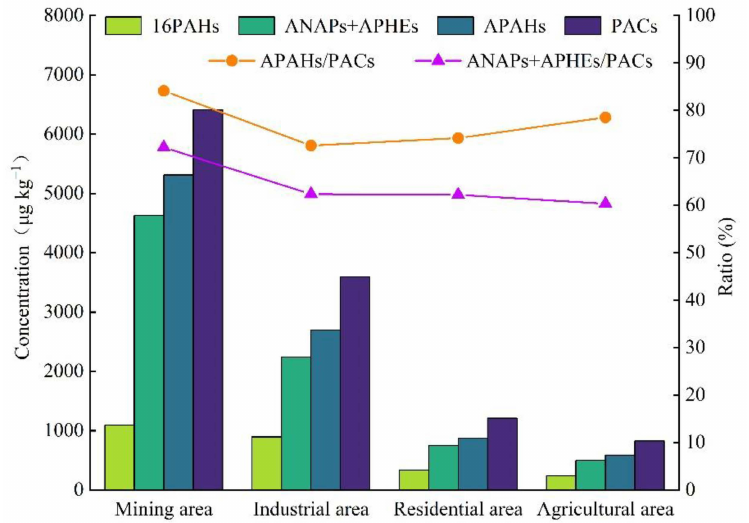
Figure 2. Concentration of 16 PAHs, APAHs, and PACs in topsoil and percentage content of APAHs and ANAPs +